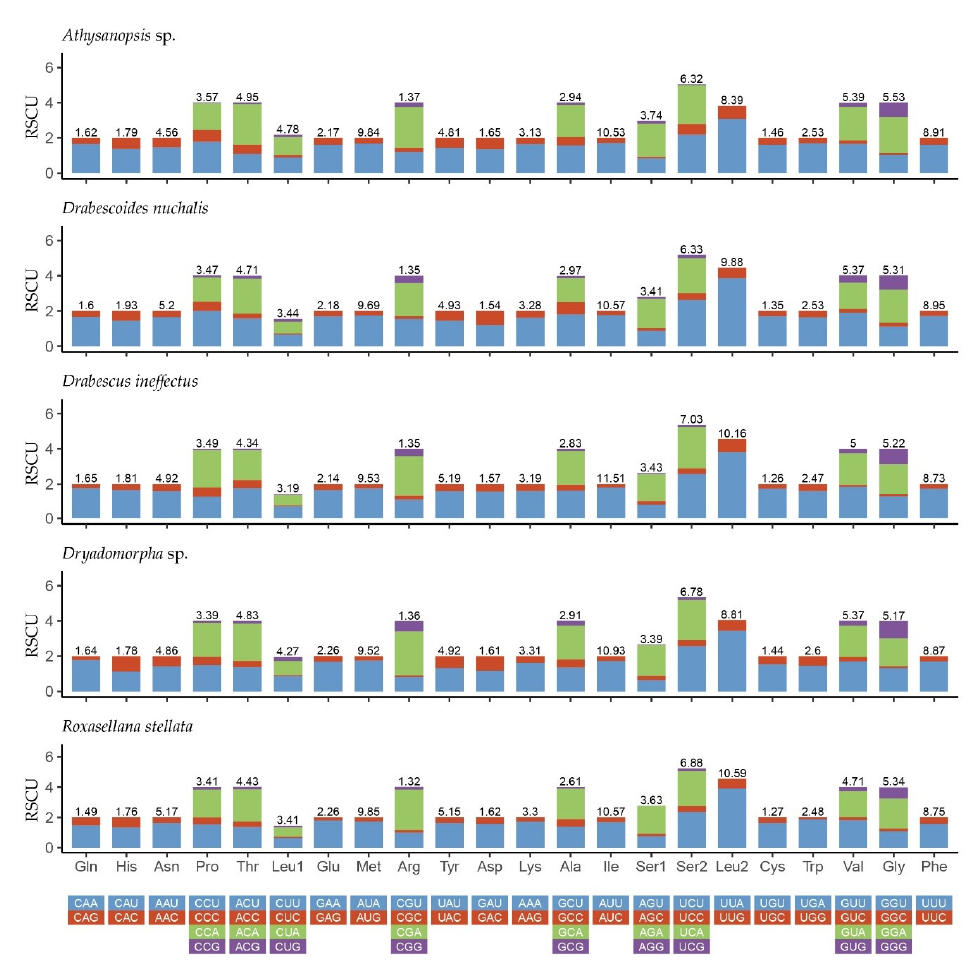
Figure 2. Relative synonymous codon usage (RSCU) in the mitogenomes of five Drabescini species.